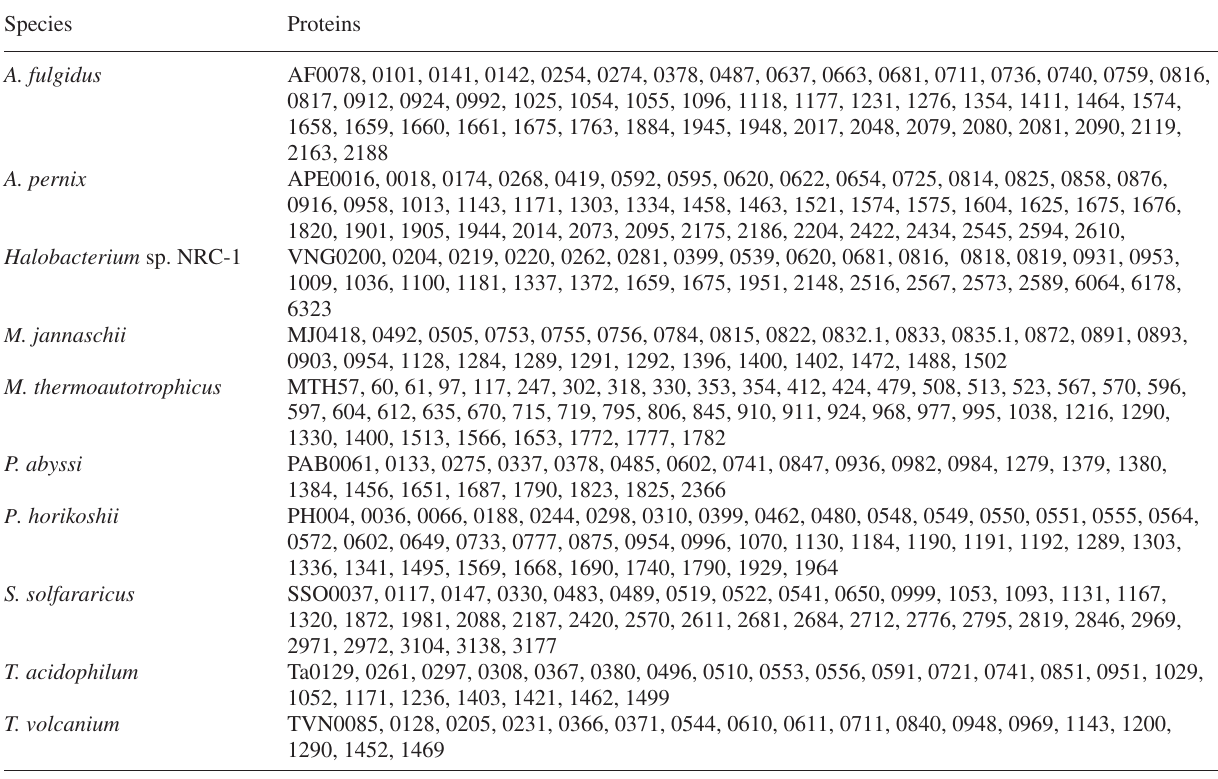
Table A2. Putative N -glycosylated predicted secretory proteins. Species